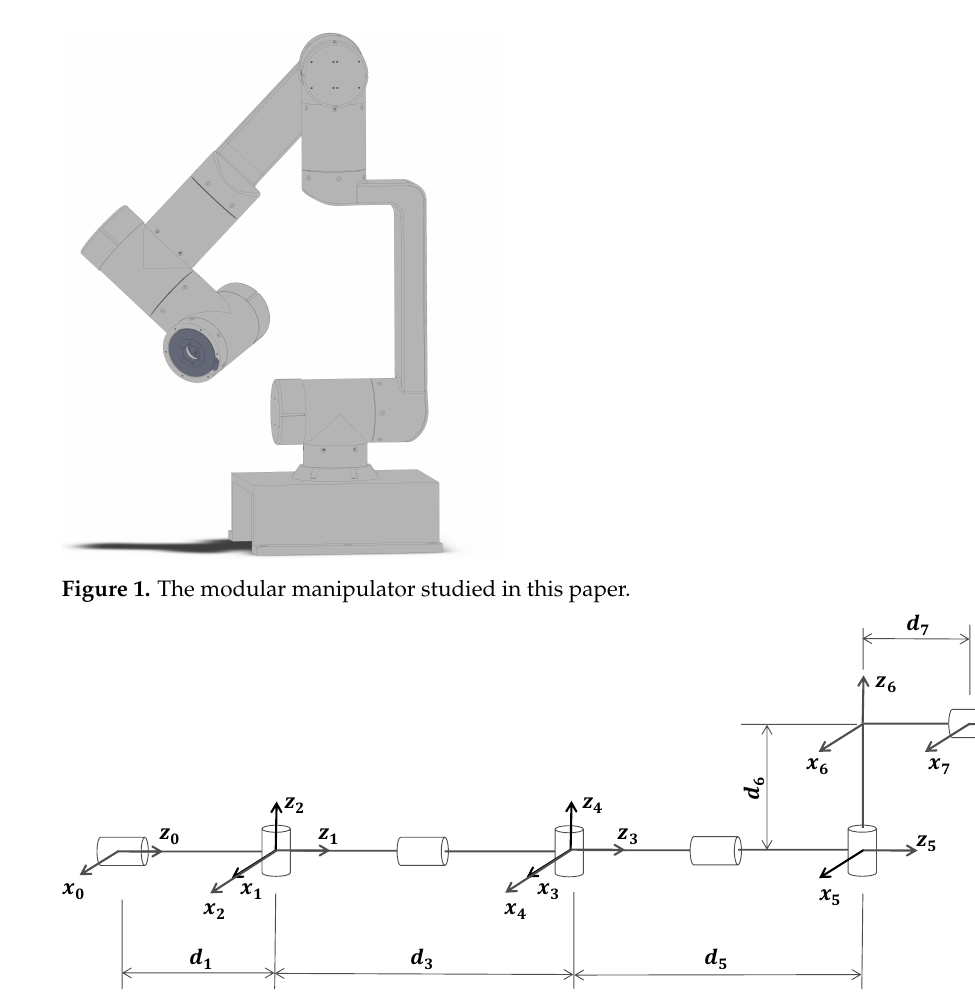
Figure 2. The initial D-H model of the modular manipulator.